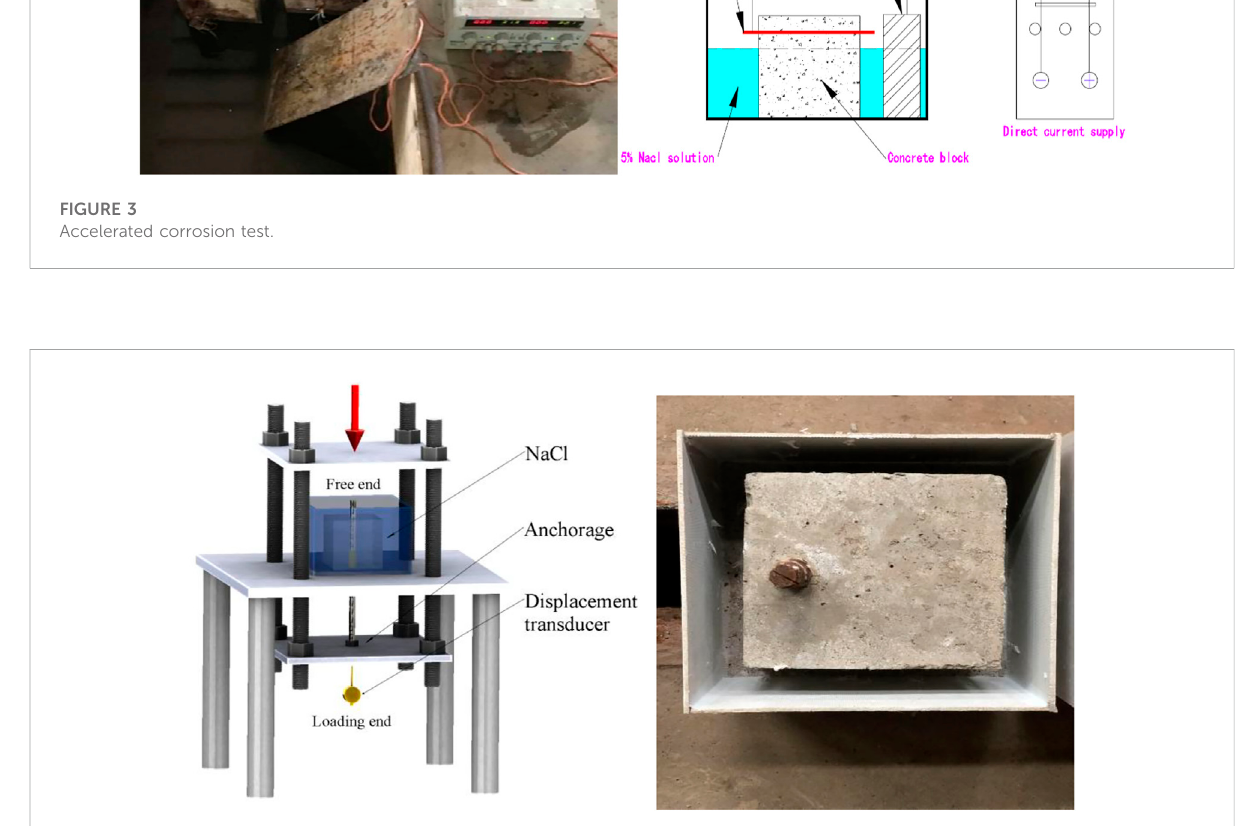
FIGURE 4 Combined action loading